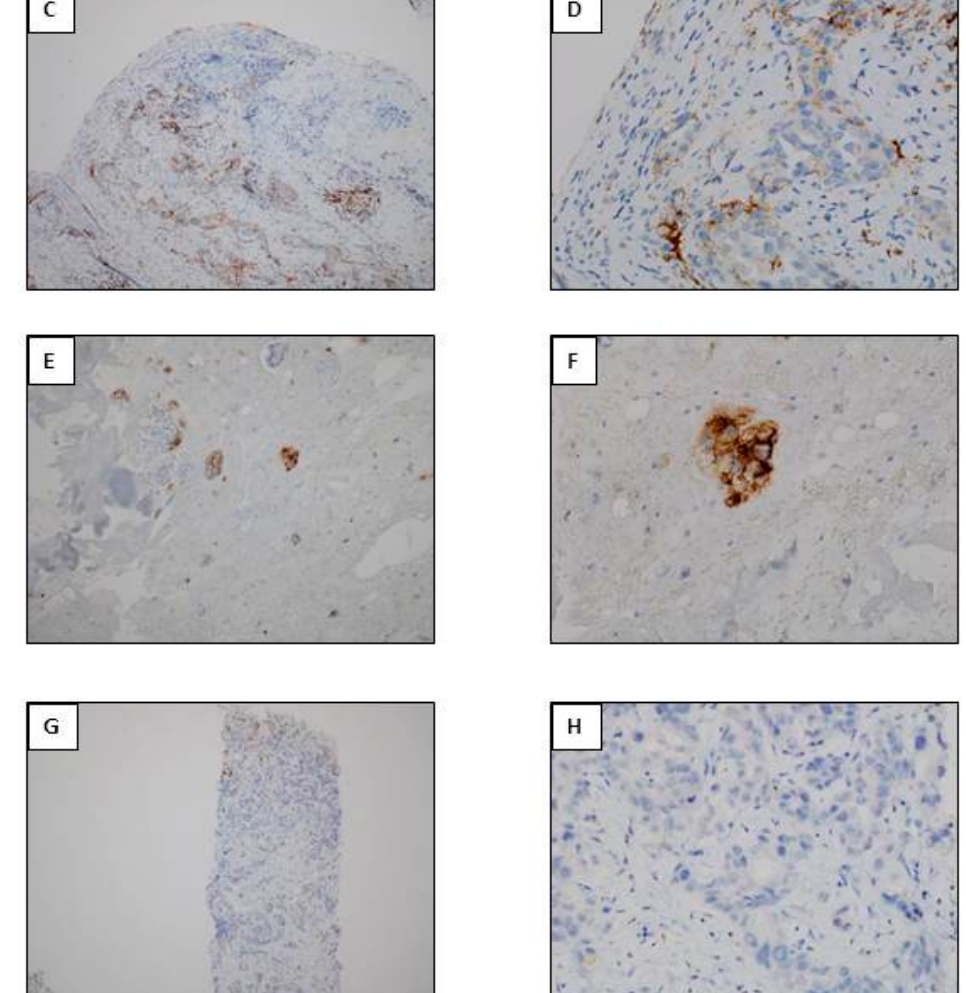
Figure 4. PD-L1 IHC (PD-L1 IHC 22C3 pharmDx, Agilent Technologies, Inc., Santa Clara, CA, USA). ( A , B ) Positivity of more than 50% of tumor cells. ( C , D ). Positivity of more than 1% and less than 50% of tumor cells. ( E , F ) Positivity of a few cells of a lymphangitis carcinoma. ( G , H ) Negative IHC. ( A , C , E , G ) immunoperoxisase, magnification × 100; ( B , D , F , H ) immunoperoxidase, magnification ×